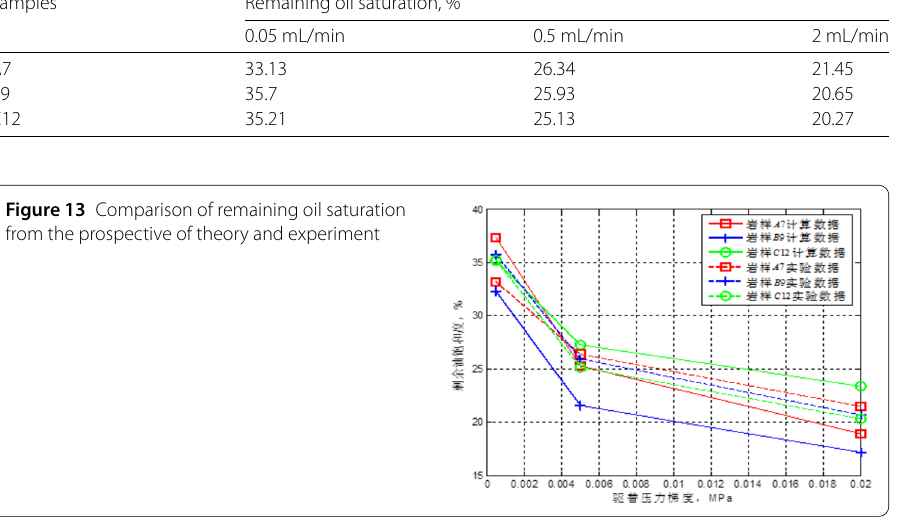
Table 4 Remaining oil saturation with NMR experiment Samples